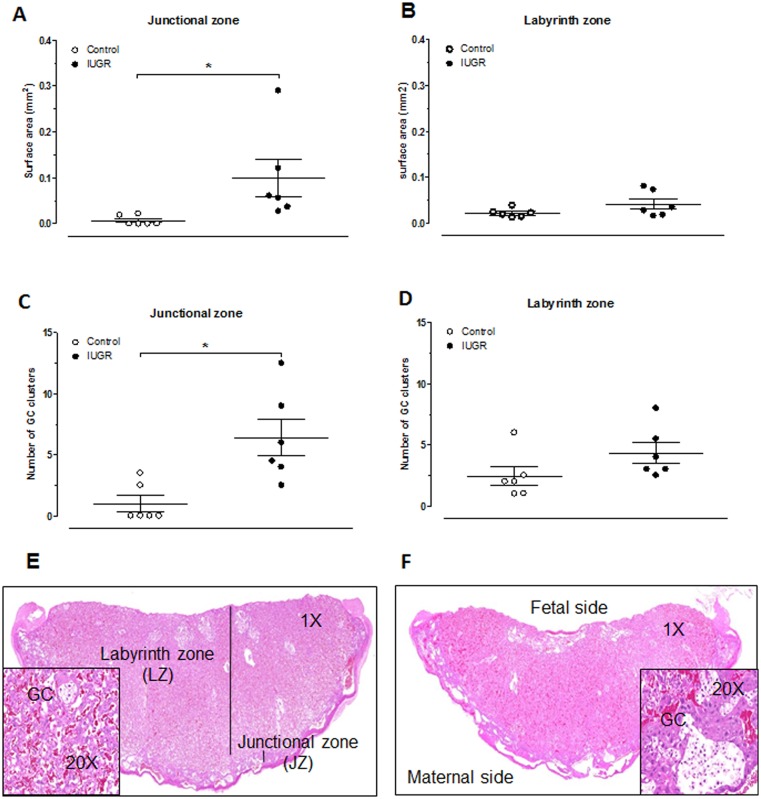
Presence of glycogen cell clusters (GC) in placenta from control and IUGR 22-day pregnant rats.Surface area of GC clusters in junctional (A) and labyrinth (B) zones. Number of GC clusters in junctional (C) and labyrinth (D) zones. Each point represents one placenta. Results are expressed as means ± SEM from 6 rats/group. *P<0.05 vs. control pregnant rat, Student’s t test. Representative placenta of control (E) and IUGR (F) rat (HE stain).